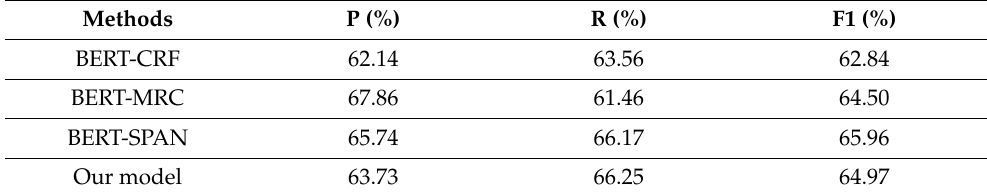
Table 6. The comparison between our model and recent SOTA models on CMeEE. Methods